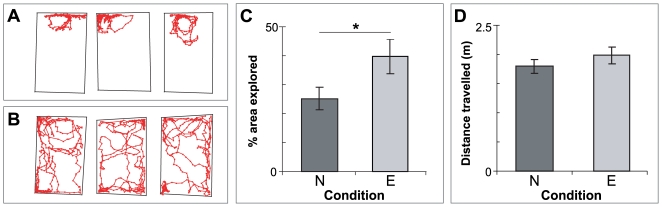
Enrichment increases exploratory behaviour in an ‘open field’ test in young mice.Representative traces (red) of (A) non-enriched and (B) enriched P10 mice. Enriched mice typically traverse a much higher proportion of the test arena than non-enriched mice. (C) Percentage of area explored for non-enriched (‘N’, n = 17) and enriched (‘E’, n = 17) P10 mice, as obtained from the traces. The increase in the percentage of the open-field explored by enriched mice is statistically significant (t-test, p = 0.0237). *: p<0.03. (D) Total cumulative distance travelled by non-enriched and enriched mice. There was no detectable difference in absolute distance travelled between the two groups (Student's t-test, p = 0.334).